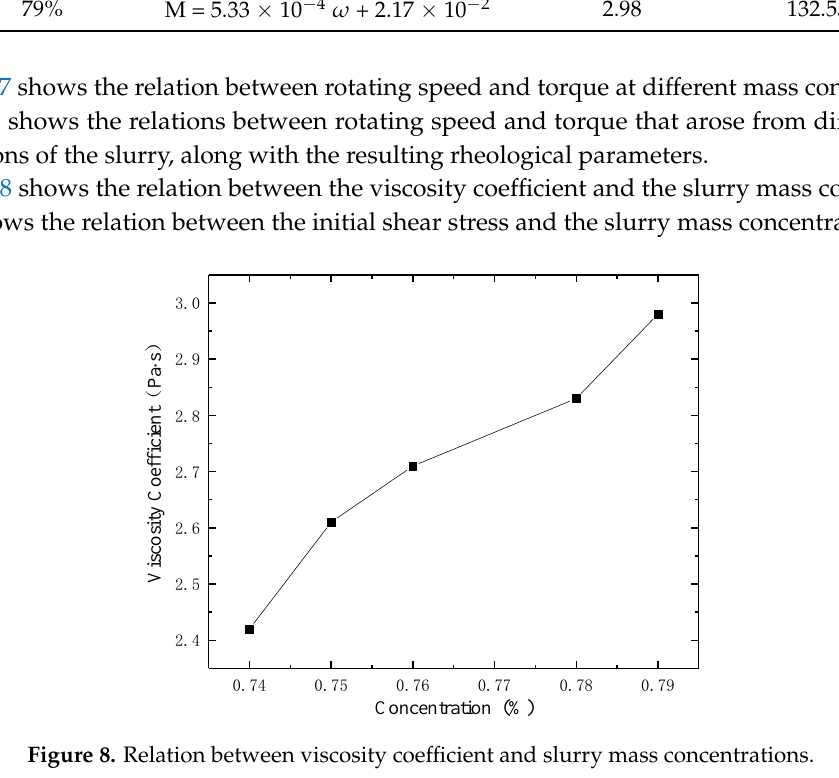
Figure 8. Relation between viscosity coefficient and slurry mass concentrations.